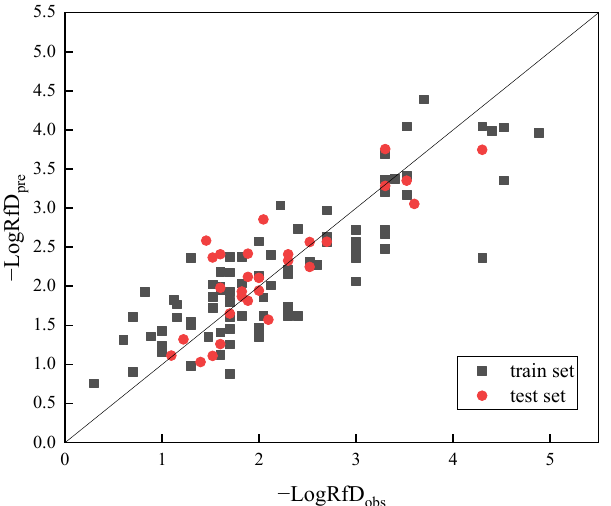
Figure 1. Graphical representation of predicted − logRfD versus observed − logRfD. The squares refer to data in training set and the dots are data in test set. The actual and predicted values of the negative logarithm of RfD are the abscissa and ordinate, respectively.